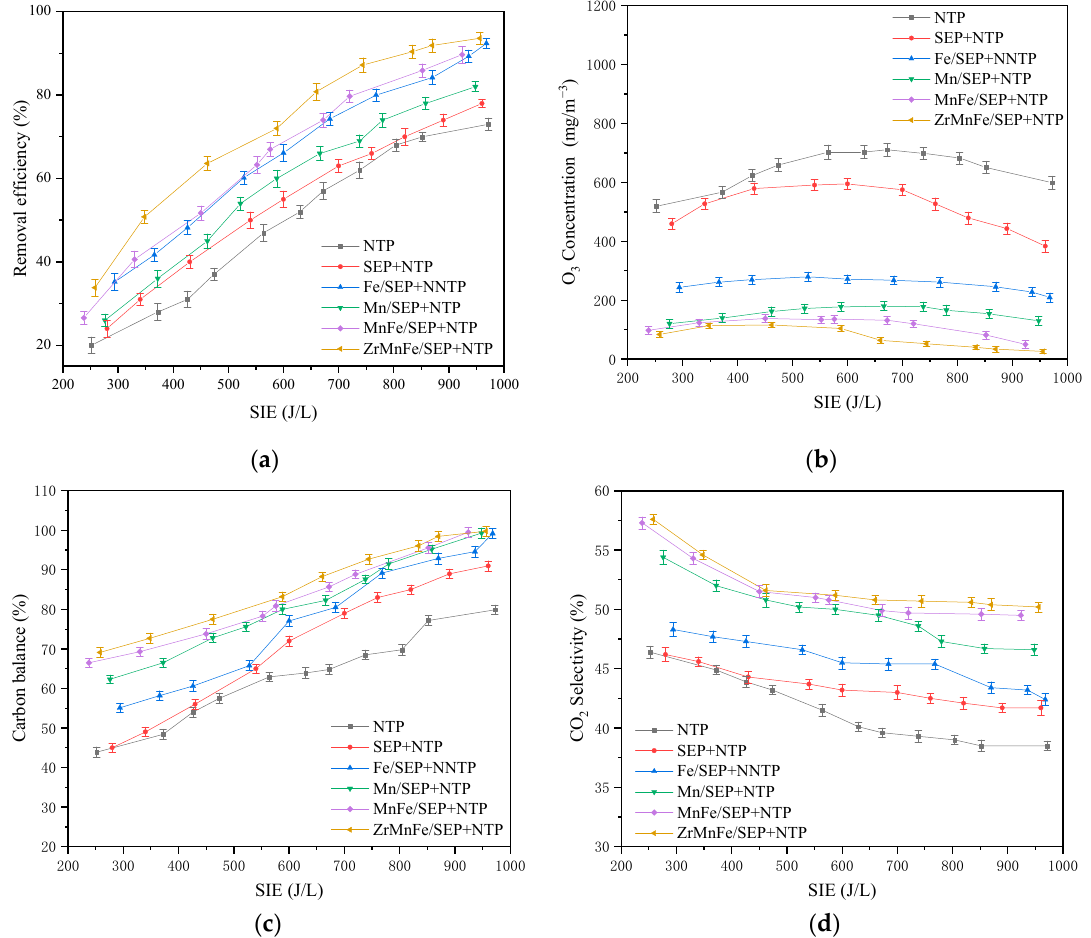
Figure 1. Effect of catalyst position on toluene removal (RH = 6% and T = 20 ± 2 °C ): ( a ) removal efficiency; ( b ) ozone concentration; ( c ) carbon balance; ( d ) CO 2 selectivity.